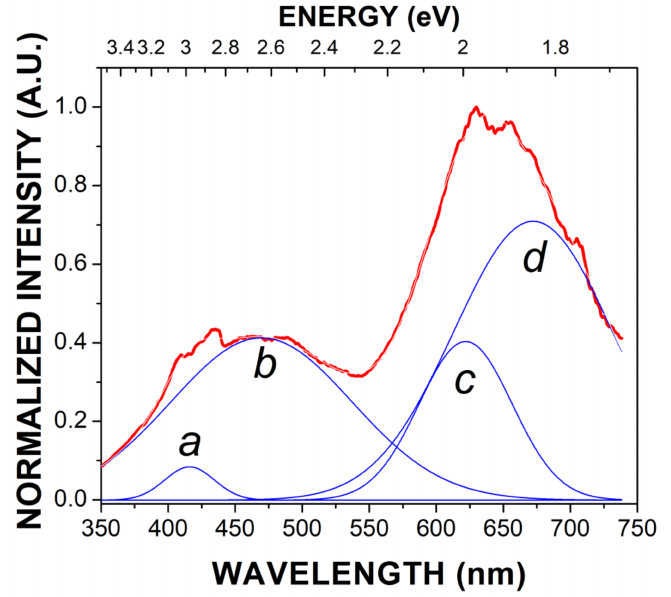
Figure 8. Photoluminescence spectrum for the Zn-doped GaN films deposited by radio-frequency magnetron